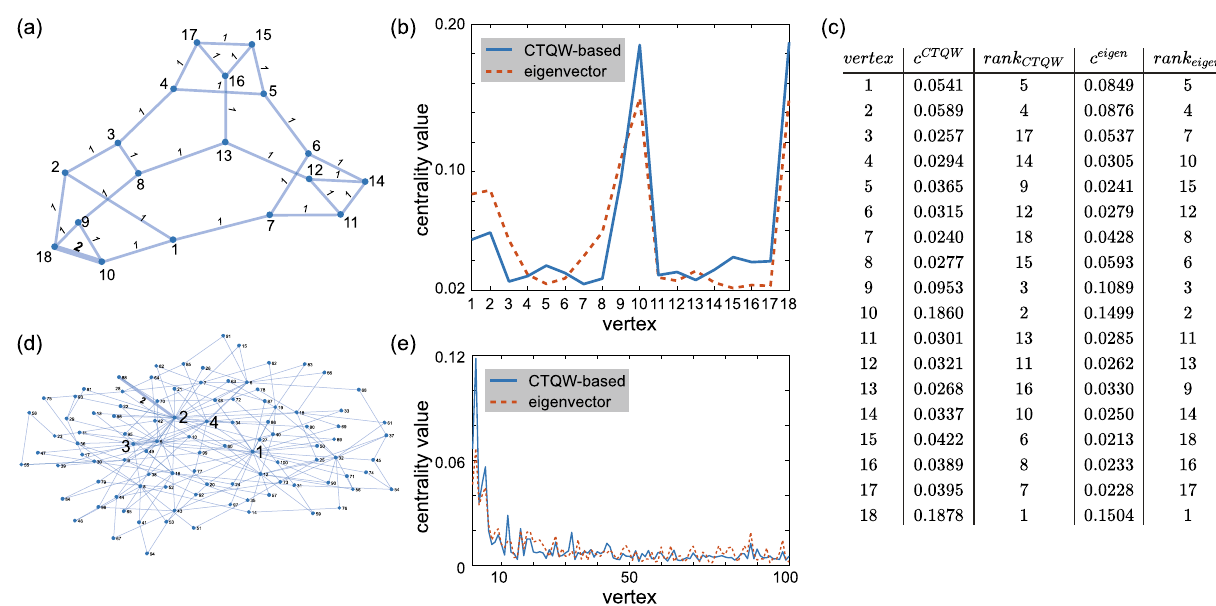
Figure 3. ( a ) The cubic planar graph with the minimal τ w Kendall of all the tested cubic planar graphs. ( b ) The eigenvector centralities (dotted red line) and CTQW-based centralities (solid blue line) for vertices of the graph in ( a ). ( c ) The ranking orders for the vertices of the graph in ( a ) by the eigenvector centrality measure and CTQW-based centrality measure. ( d ) The scale-free network SF (100, 2) with the minimal τ w Kendall of all the tested SF (100, 2) with only one edge weighted 2. (e) The eigenvector centralities (dotted red line) and CTQW-based centralities (solid blue line) for vertices of the graph in ( d